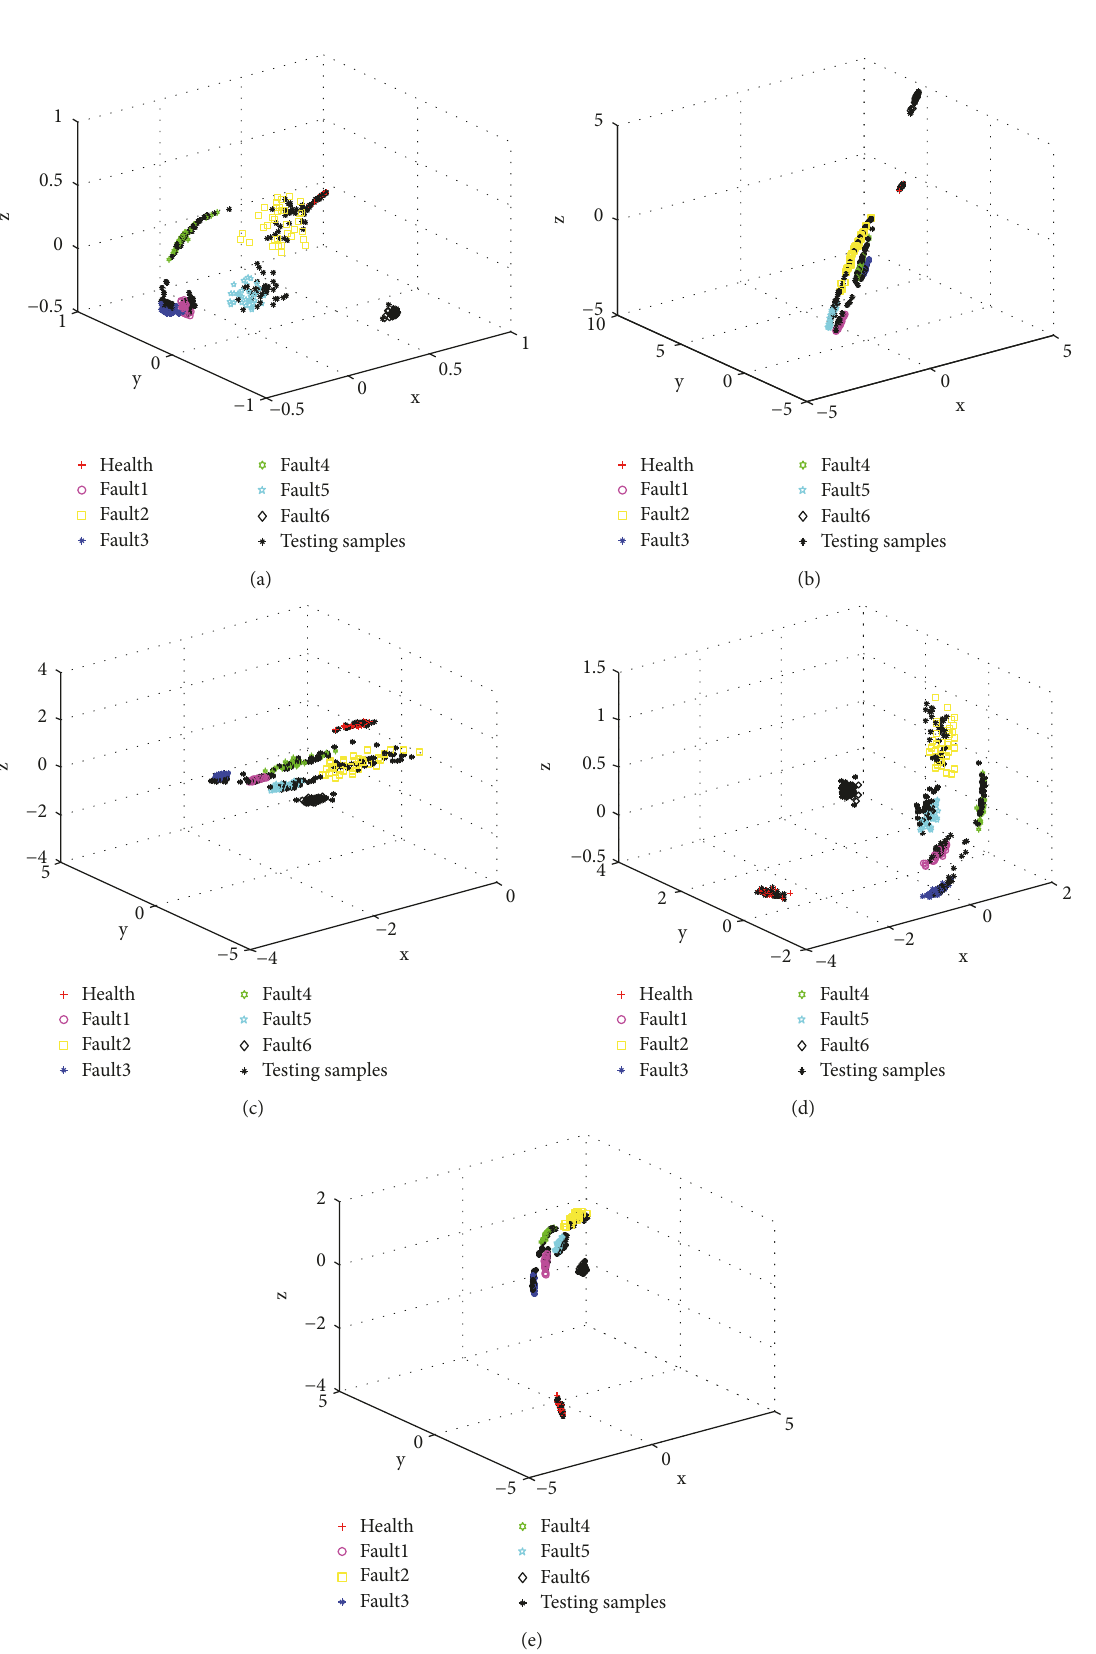
Figure 4: Three-dimensional representation based on the three features extracted from the training and testing samples by (a) KPCA, (b) KONPE, (c) NLOPE, (d) KGLPP, and (e)